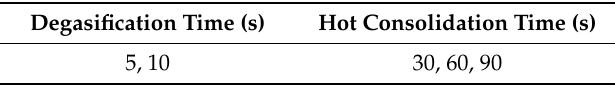
Table 2. Rapid sinter pressing (RSP) time processing parameters tested.